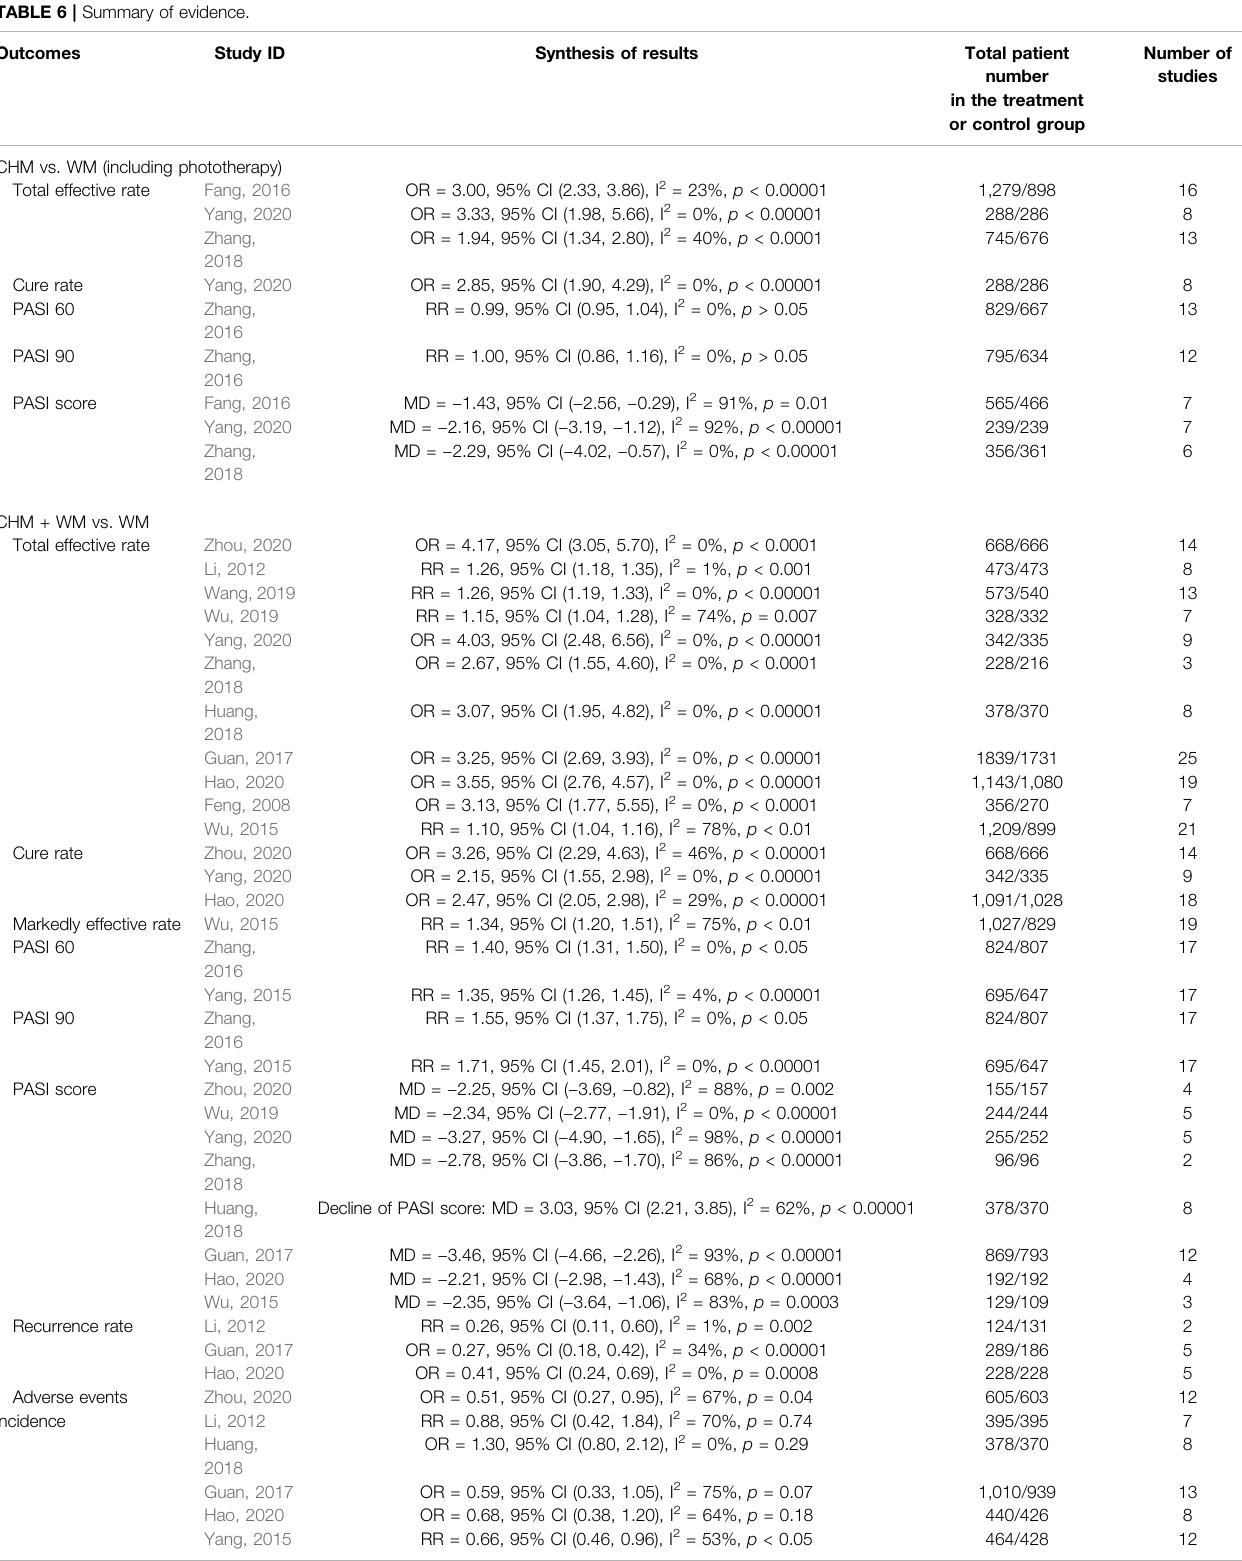
TABLE 6 | Summary of evidence.